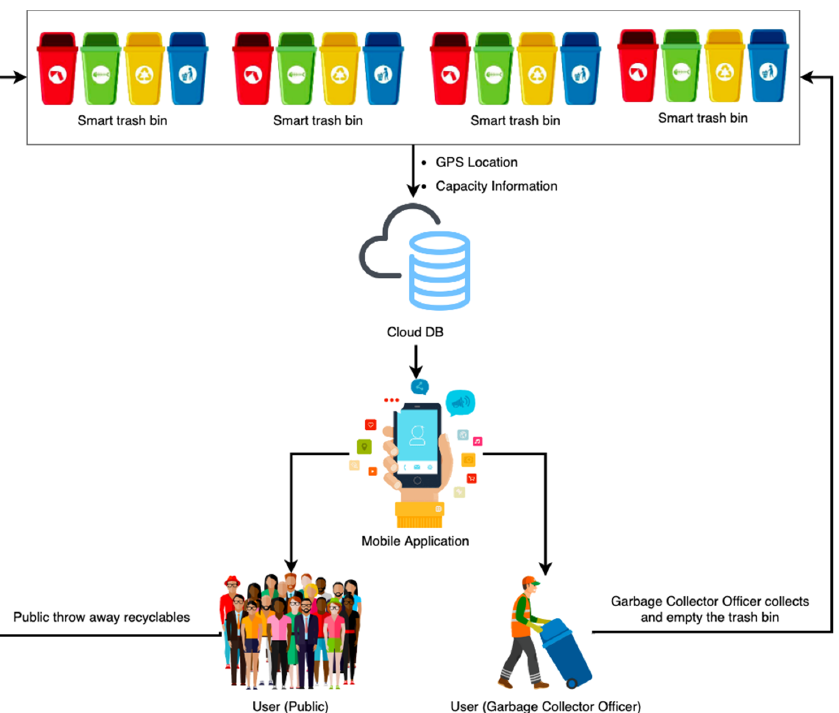
Figure 3. End ‐ to ‐ end diagram. Figure 3. End-to-end